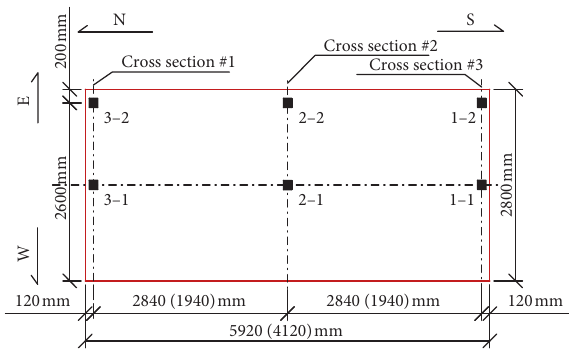
Figure 14: Measuring sensor arrangement. Table 3: Test loading acted on the unballasted tracks.